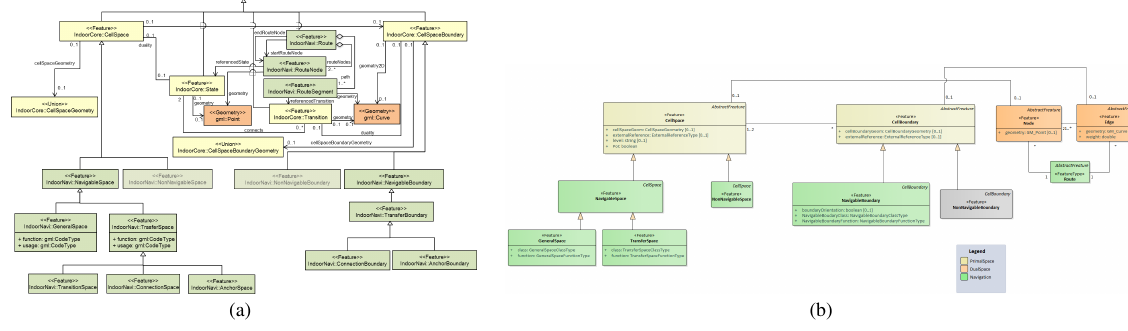
Figure 2. UML diagrams of the Navigation module of (a) IndoorGML 1.x and (b) IndoorGML